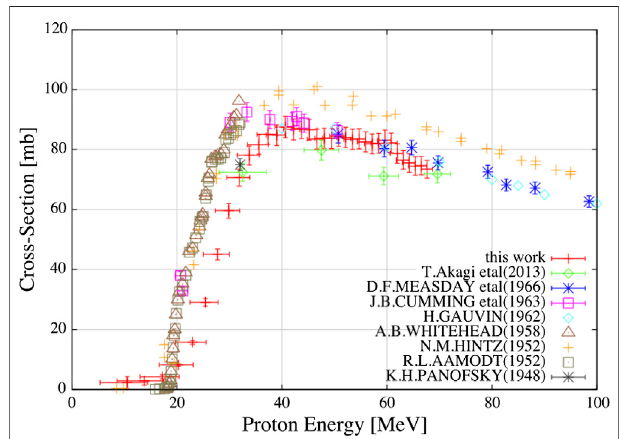
FIGURE 3 | Cross section measurements for 11 C from different groups in the past 70 years, with new recent measurements included. Reproduced with permission from Matsushita et al. [133] Discrepancies between various measurements are